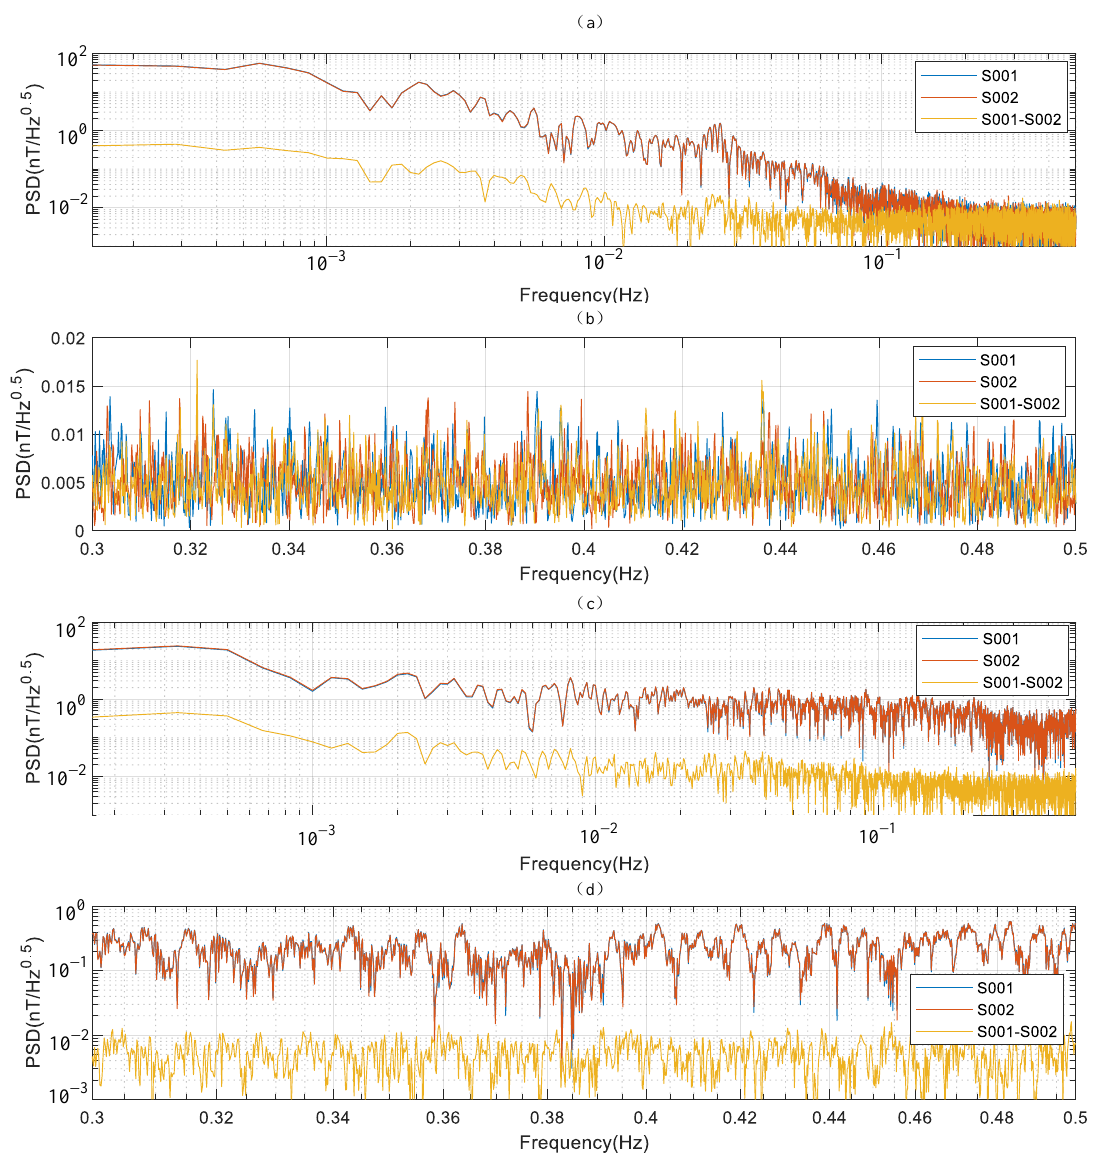
Figure 19. ( a ) PSDs under quiet environment, ( b ) high-frequency components of PSDs under quiet environment, ( c ) PSDs under noisy environment, ( d ) high-frequency components of PSDs under noisy environment.